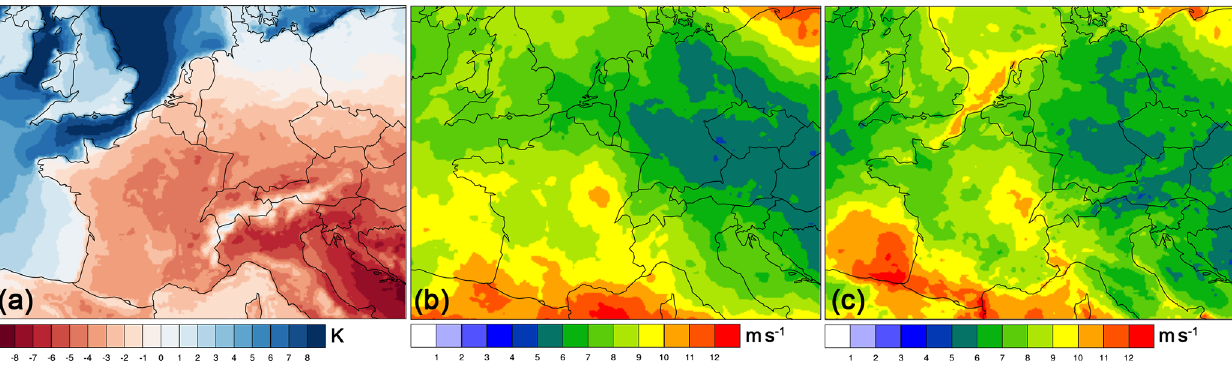
Figure 8. (a) Surface-based lifted index (SLI in K), (b) horizontal wind speed at 500hPa ( V 500 in ms − 1 ), and (c) bulk wind shear between 500hPa and 10m (BWS in ms − 1 ) at 12:00UTC averaged over the study period from 22 May to 12 June 2018 (ECMWF analysis).